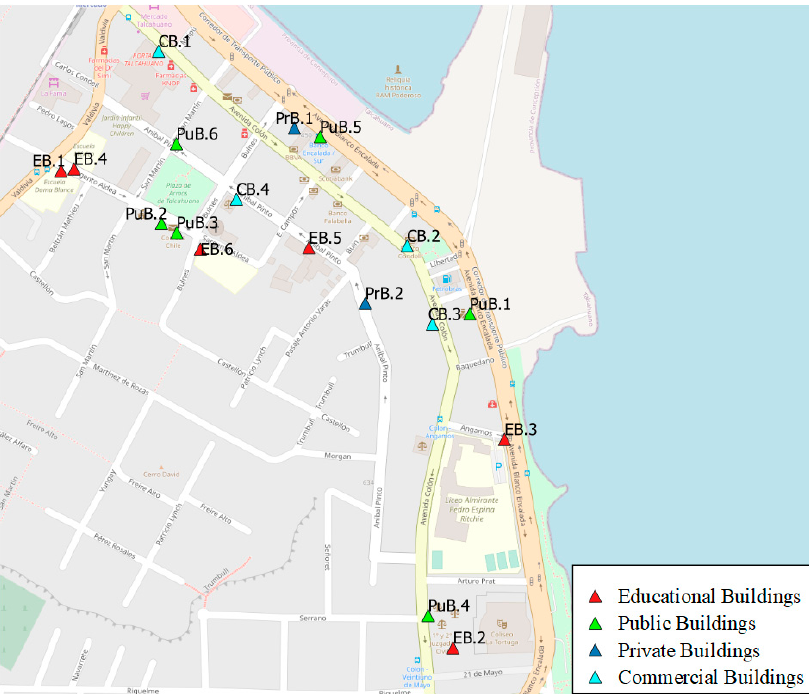
Figure 4. Buildings’ location in the study area.